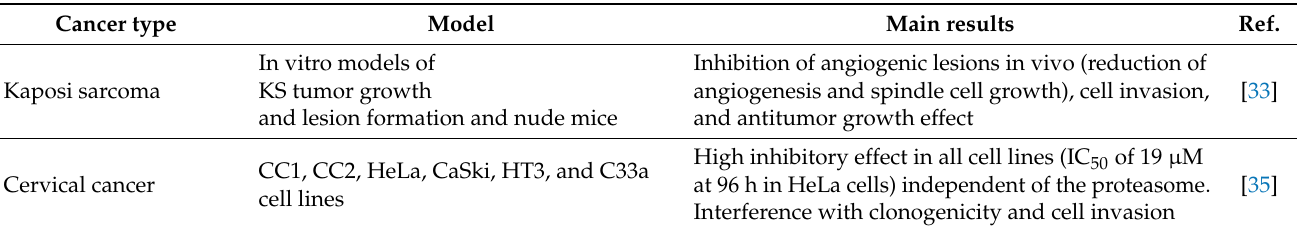
Table 1. Works on the repurposing of saquinavir for anticancer